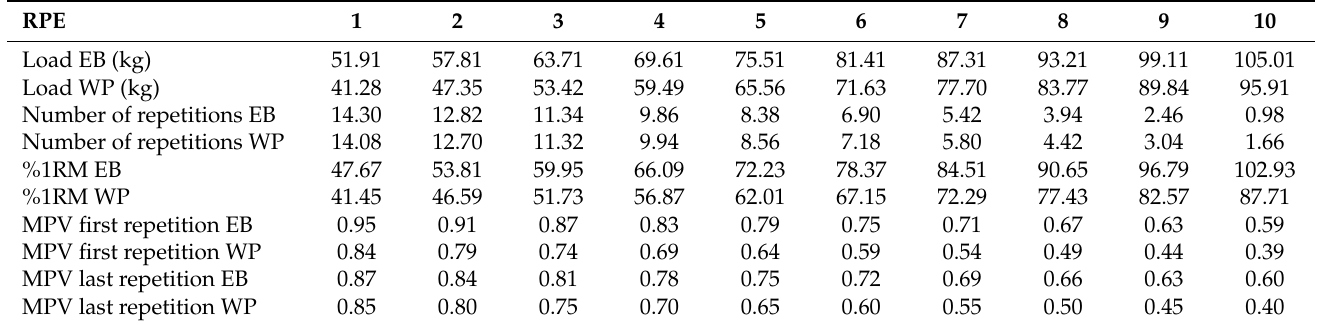
Table 4. Rating of perceived exertion (RPE) equivalences for load, number of repetitions, %1RM, and MPV from the categorical linear regression